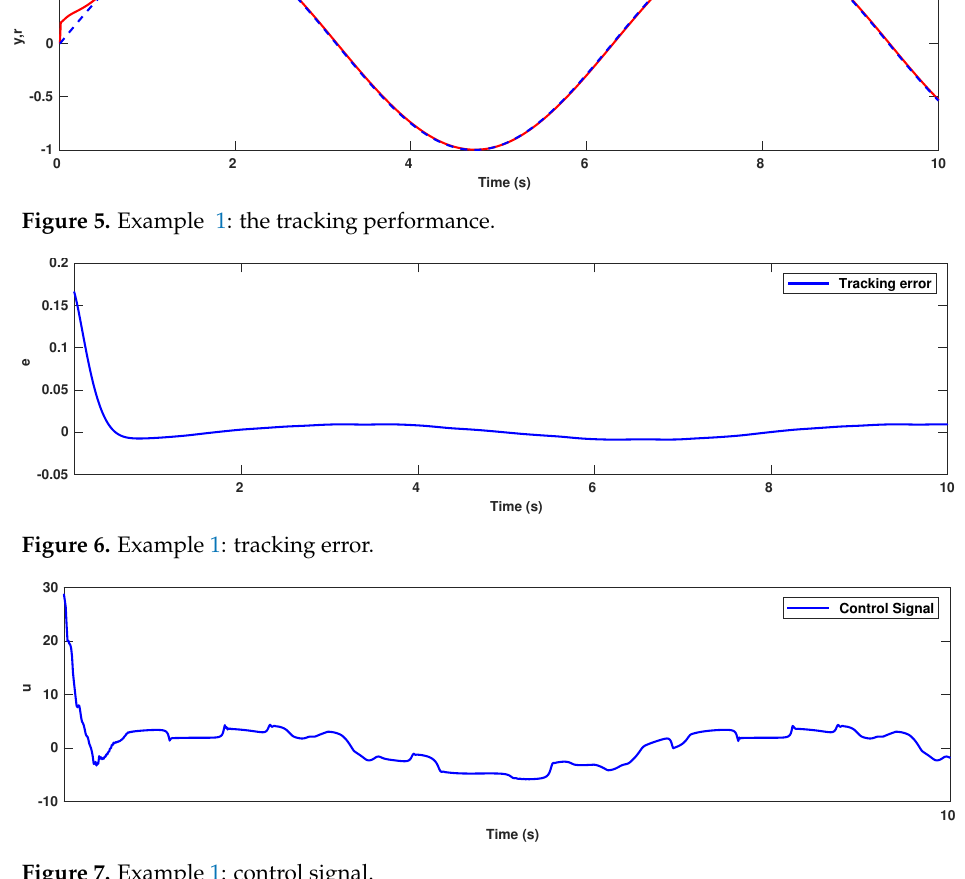
Figure 7. Example 1: control